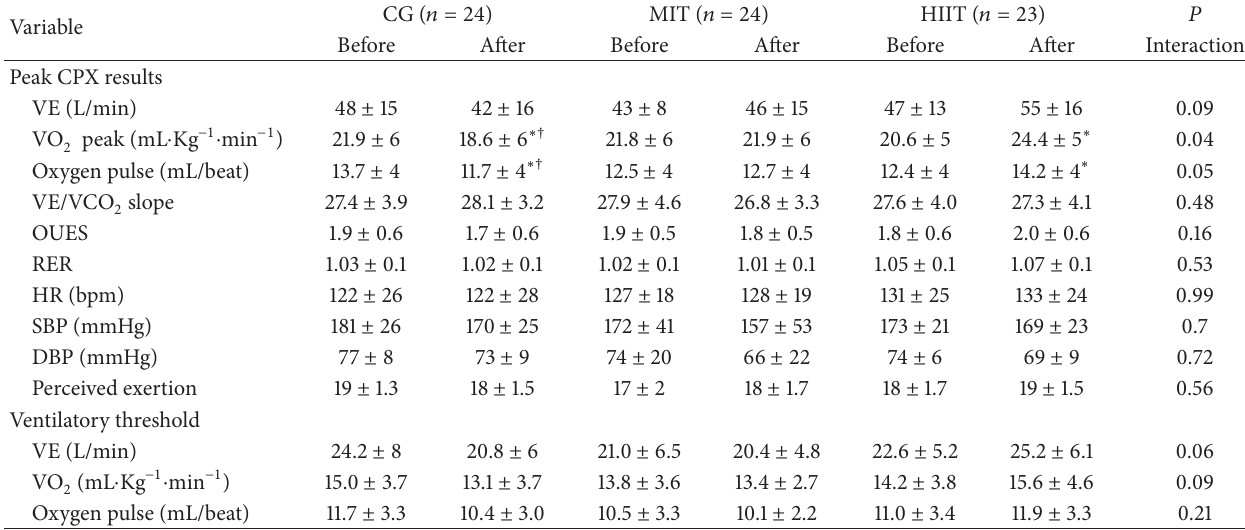
Table 2: Ventilatory results of CPX at peak and ventilatory threshold among groups. CG ( 𝑛 = 24 ) MIT ( 𝑛 = 24 ) HIIT ( 𝑛 = 23 ) 𝑃 Variable Before After Before After Before After Interaction Peak CPX